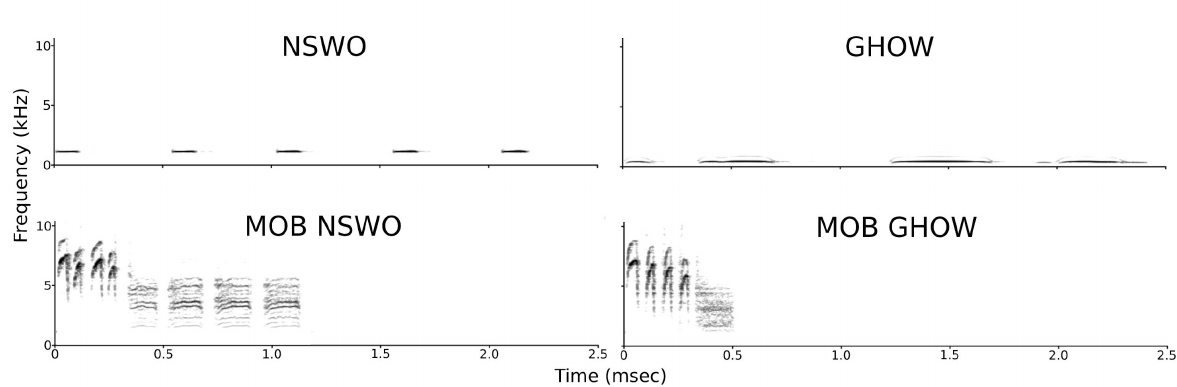
Spectrograms of Experimental